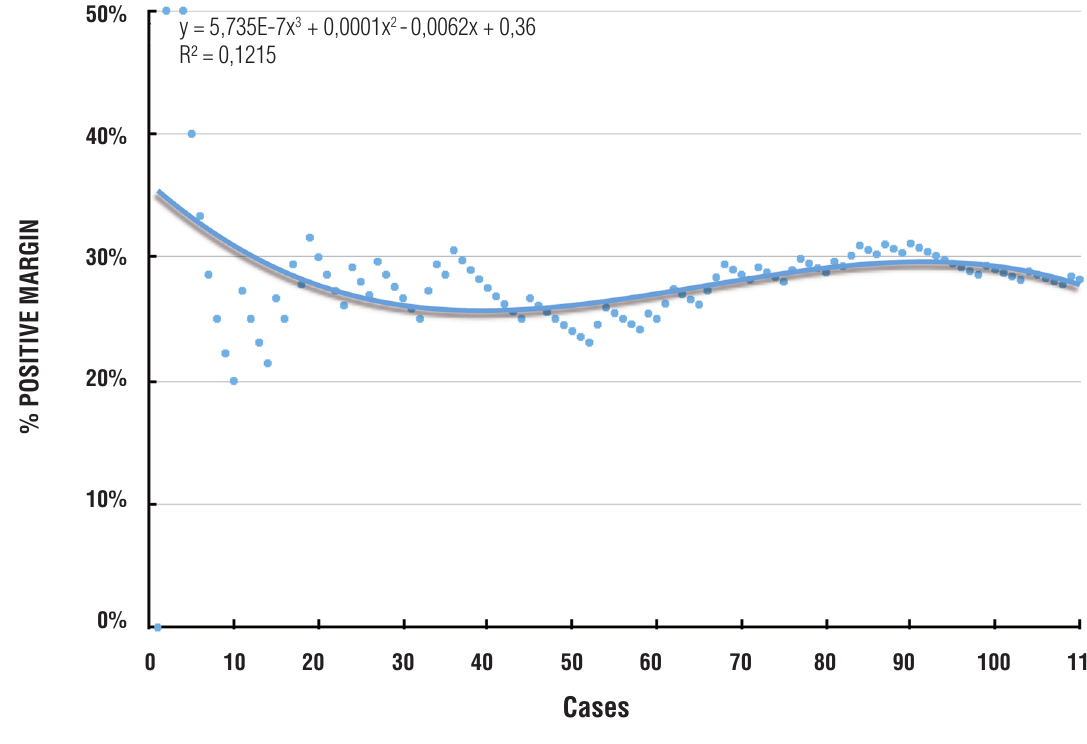
Figure 3 - Incontinence